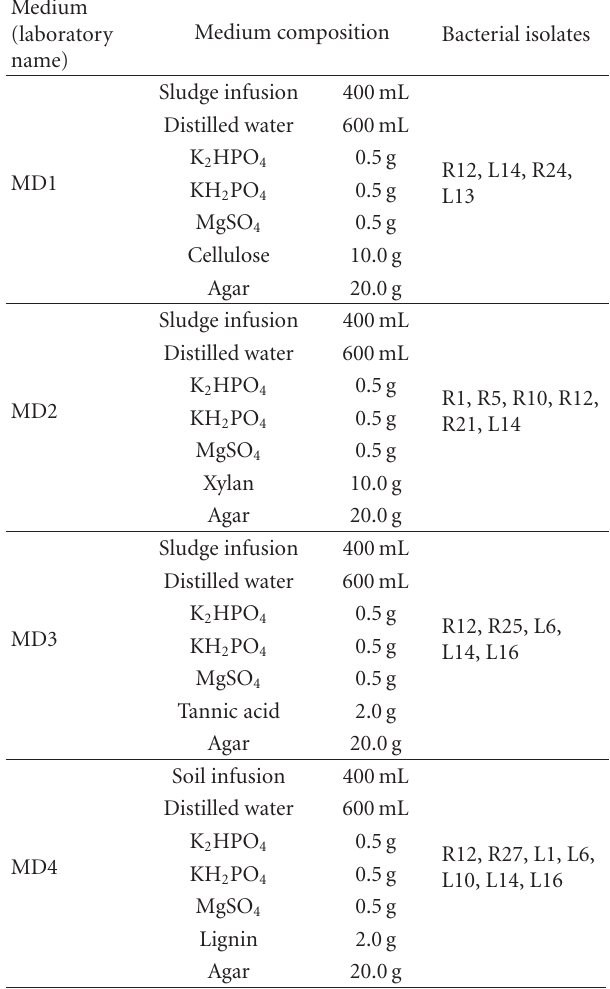
Table 1: Media used for screening of bacterial isolates for the form- ulation of consortia.